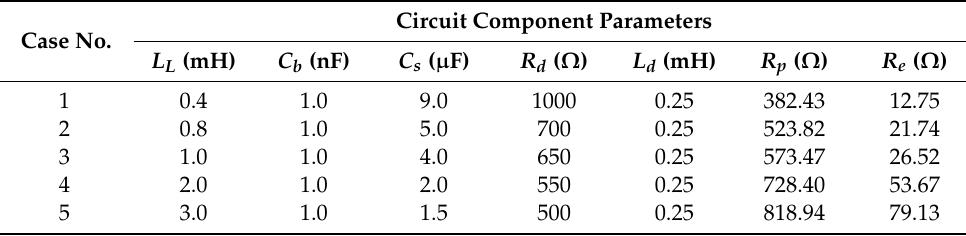
Table 4. The adjusted circuit component parameters of the generation circuit used as training data. Case